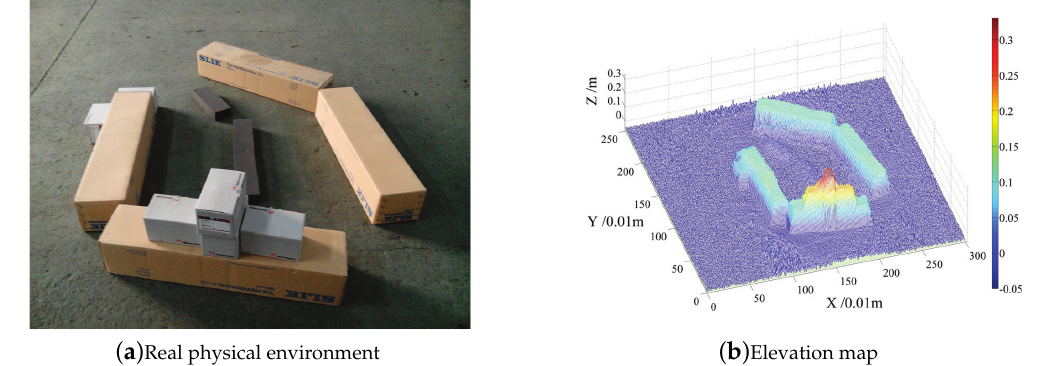
Figure 7. Terrain model for collecting training data set. ( a ) is the real terrain environment and ( b ) is the corresponding 2.5D elevation map constructed from 3D point cloud; several frames are captured around the terrain model, and they are registered using a modern SLAM algorithm